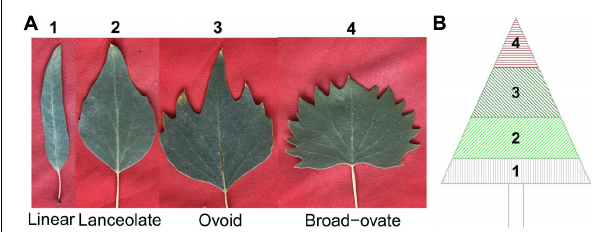
FIGURE 1 | Types and spatial distribution pattern of heterophylly in Populus euphratica . (A) An example of the four types of heterophylly in P. euphratica . (B) The spatial distribution of four types of heterophylly in the canopy of mature in P. euphratica